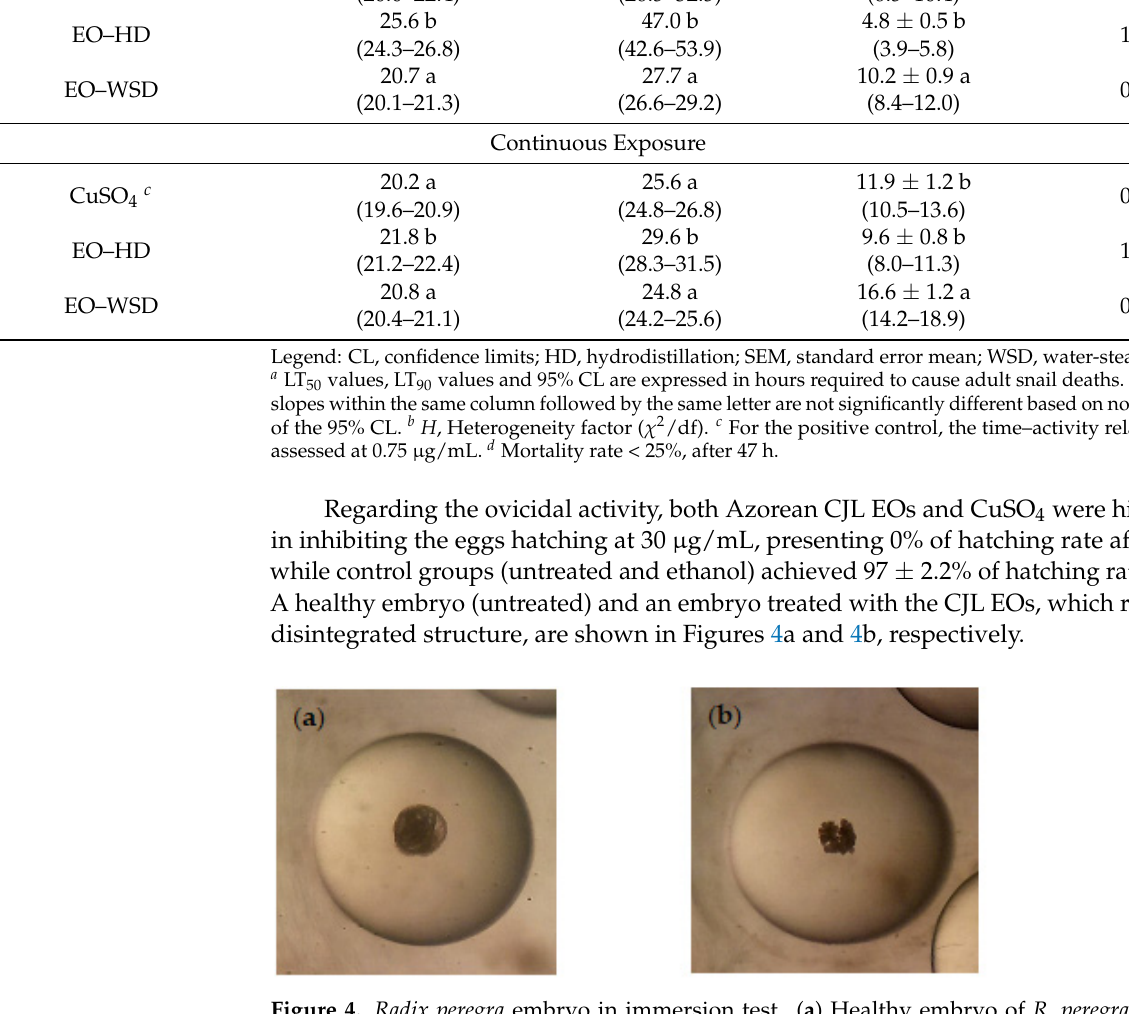
Table 4. Chemical composition (%) of Azorean Cryptomeria japonica leaf essential oils (EOs) obtained by hydrodistillation (HD) and by water-steam distillation (WSD) (adapted from Arruda et al. [13]).